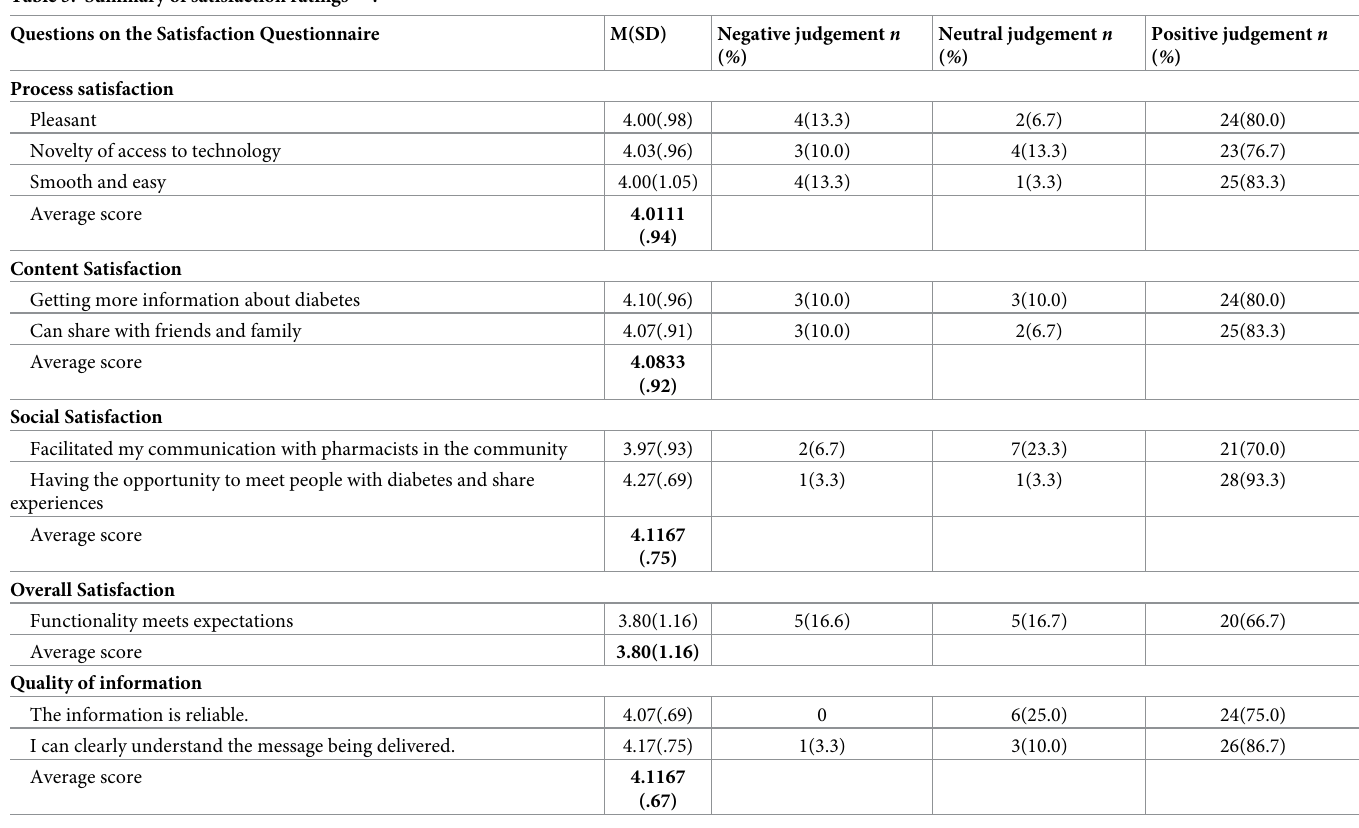
Table 3. Summary of satisfaction ratings a-b